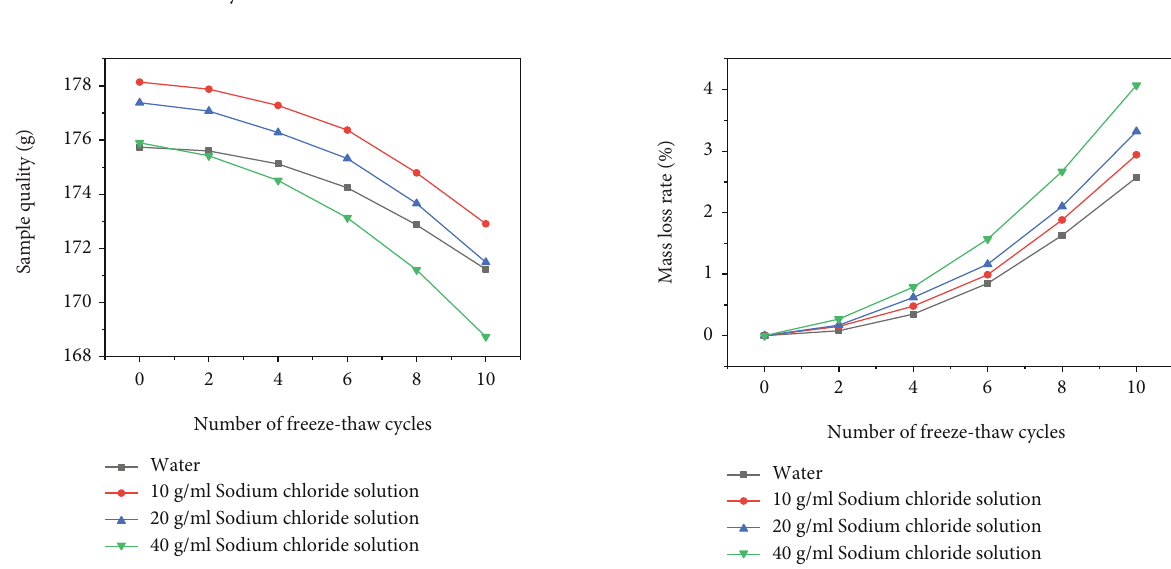
Figure 4: Sample appearance: (a) appearance diagram of sample under di ff erent concentration solutions; (b) appearance diagram of samples under di ff erent freeze-thaw cycles.